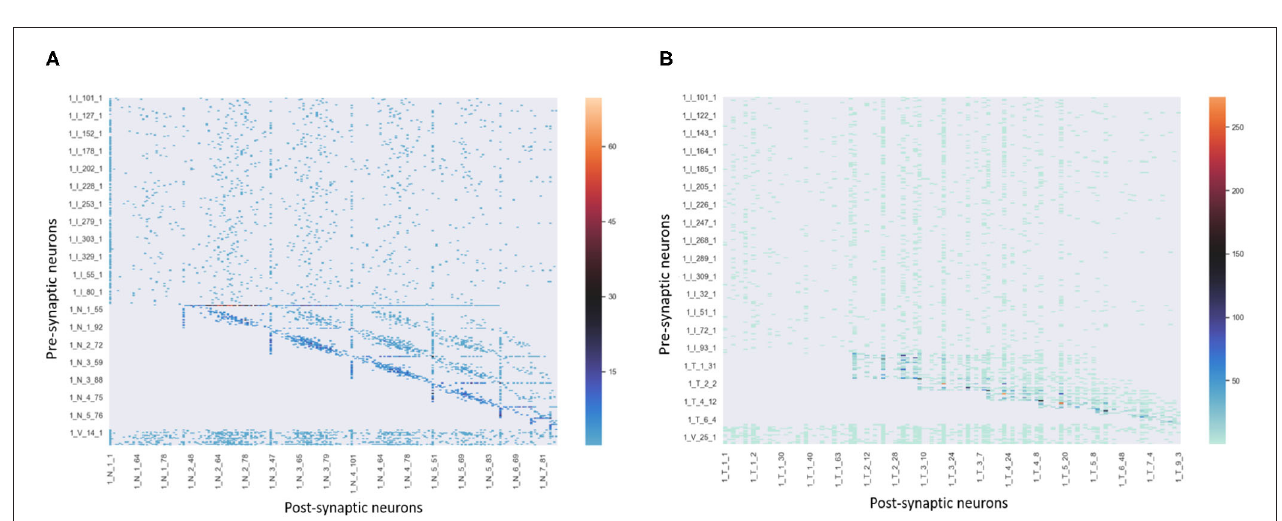
FIGURE 6 | The synaptic strengths between neurons in pitch and duration subnetworks of track 1 during learning